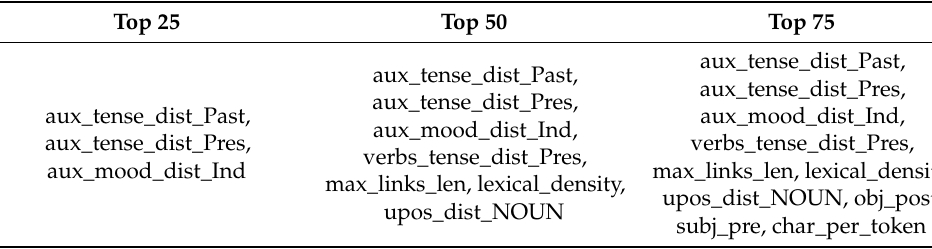
Table 7. Subgenre selection of top features.